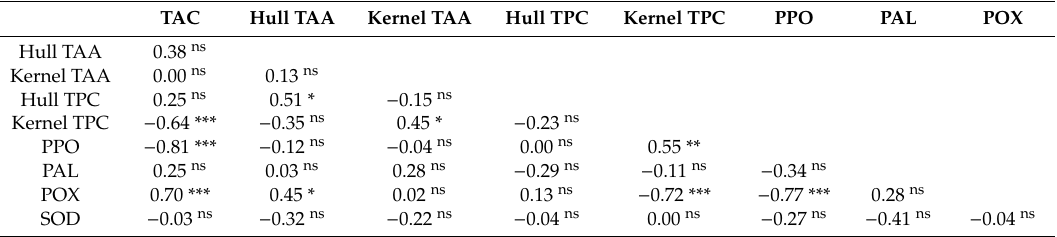
Table 7. Correlation coe ffi cients between TAC, hull TAA and hull TPC, kernel TAA and kernel TPC, PPO, PAL, POX, and SOD activity of fresh in-hull pistachios stored for 45 days at 4 ± 1 ◦ C and 90 ± 5%